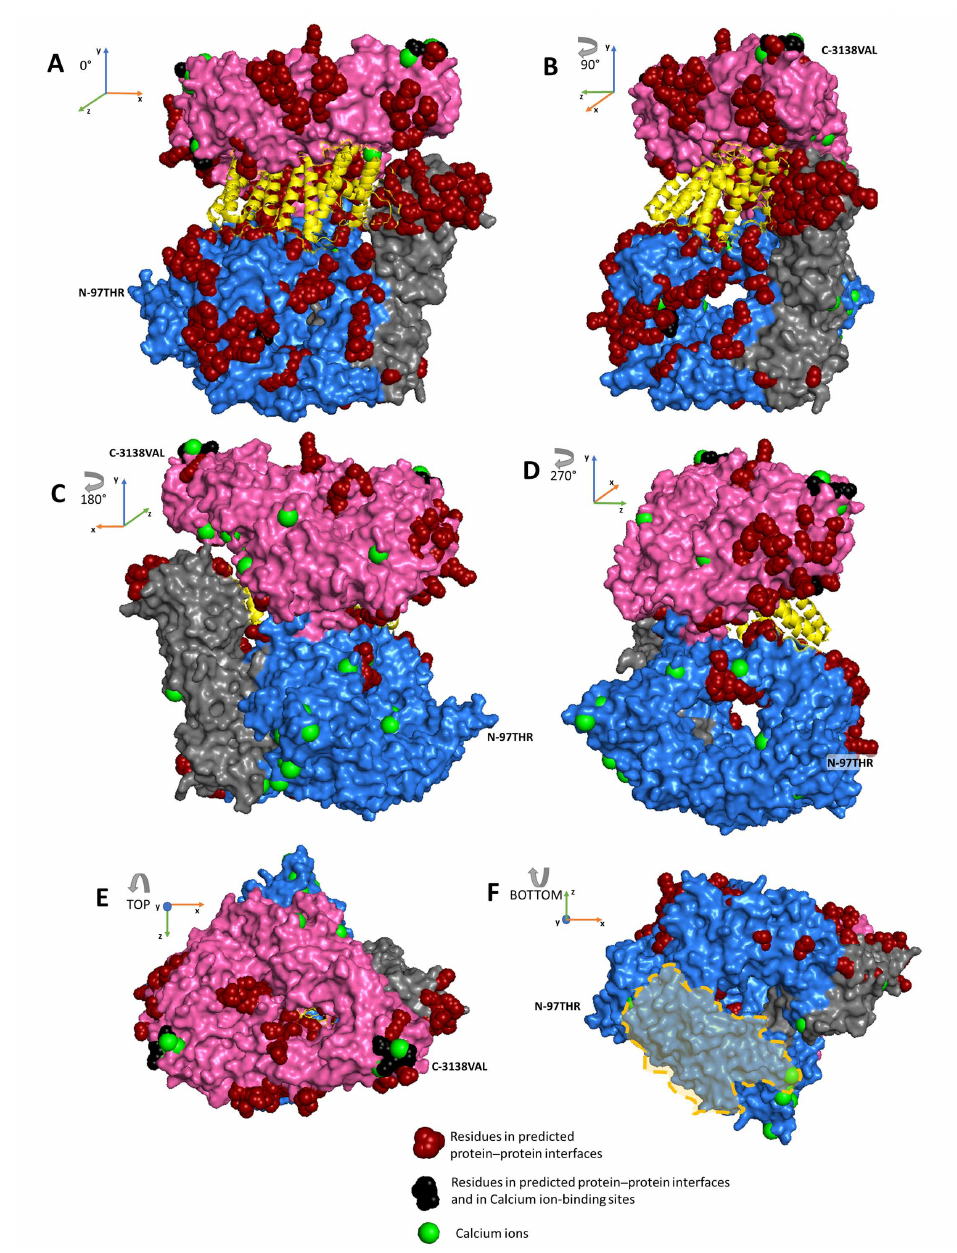
Figure 6. Interacting and calcium-biding sites over N-HEAT, C HEAT and BRIDGE huntingtin protein domains. The computed calcium-binding sites of the huntingtin protein surface. The Figure depicts the protein structure of huntingtin in complex with HTT -associated protein 40 (HAP40 , colored in yellow) [19] and captured by six different views: with a clockwise rotation of the protein around the vertical axis with 90-degree steps ( A – D ) and the top and bottom views with respect to the vertical axis ( E , F ). For domain description, see text and Guo et al., 2018 [25]. N-HEAT (pink color), C-HEAT (blue color) and BRIDGE (gray color) domains are shown according to the six different views of the protein (see Figure 2). Interacting surface residues and calcium-binding sites are color-coded as in Figure 5. The light orange area in view F indicates the membrane-binding region described by Kegel et al., 2005